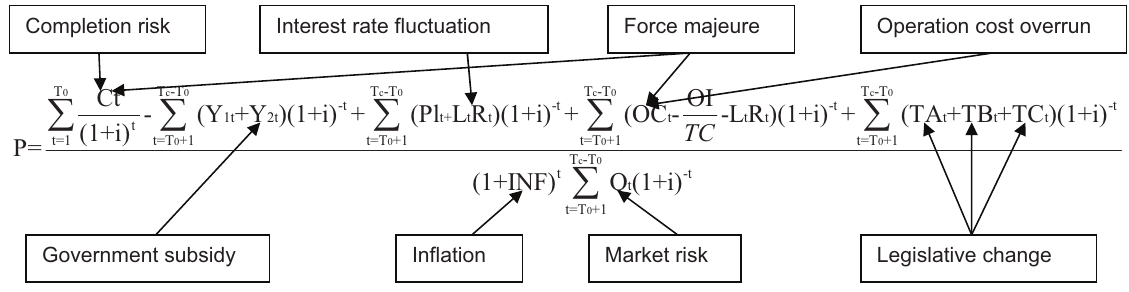
figure 5. The relationship between risk factors and concession pricing formula